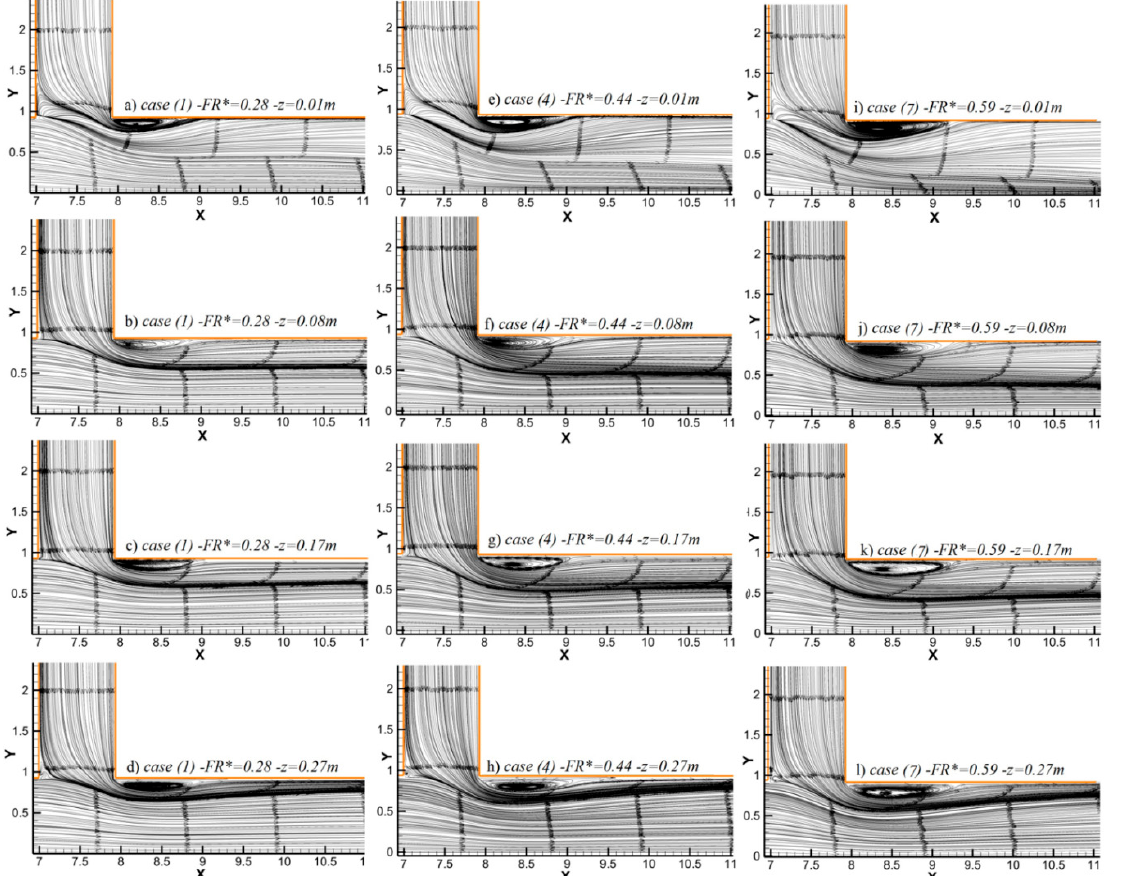
Figure 9. The effect of Fr* on the flow pattern at different elevations for ( a – d ) case 1 and ( e – h ) case 4, Figure 9. The e ff ect of Fr* on the flow pattern at di ff erent elevations for ( a – d ) case 1 and ( e – h ) case 4, and ( i – l ) case 7. and ( i – l ) case